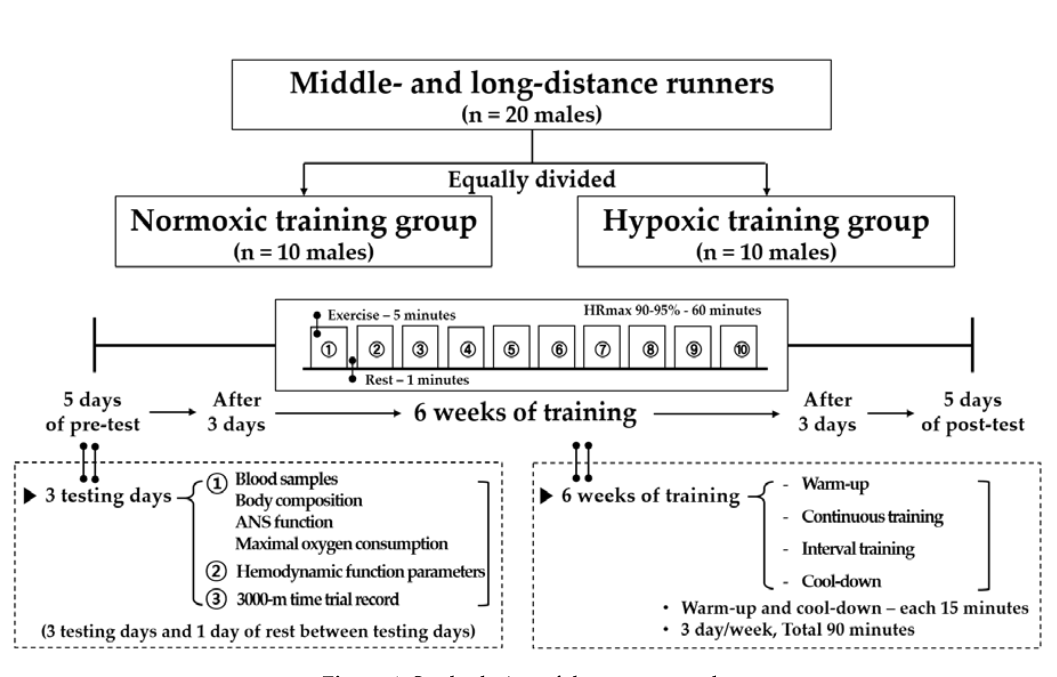
Figure 1. Study design of the present study.